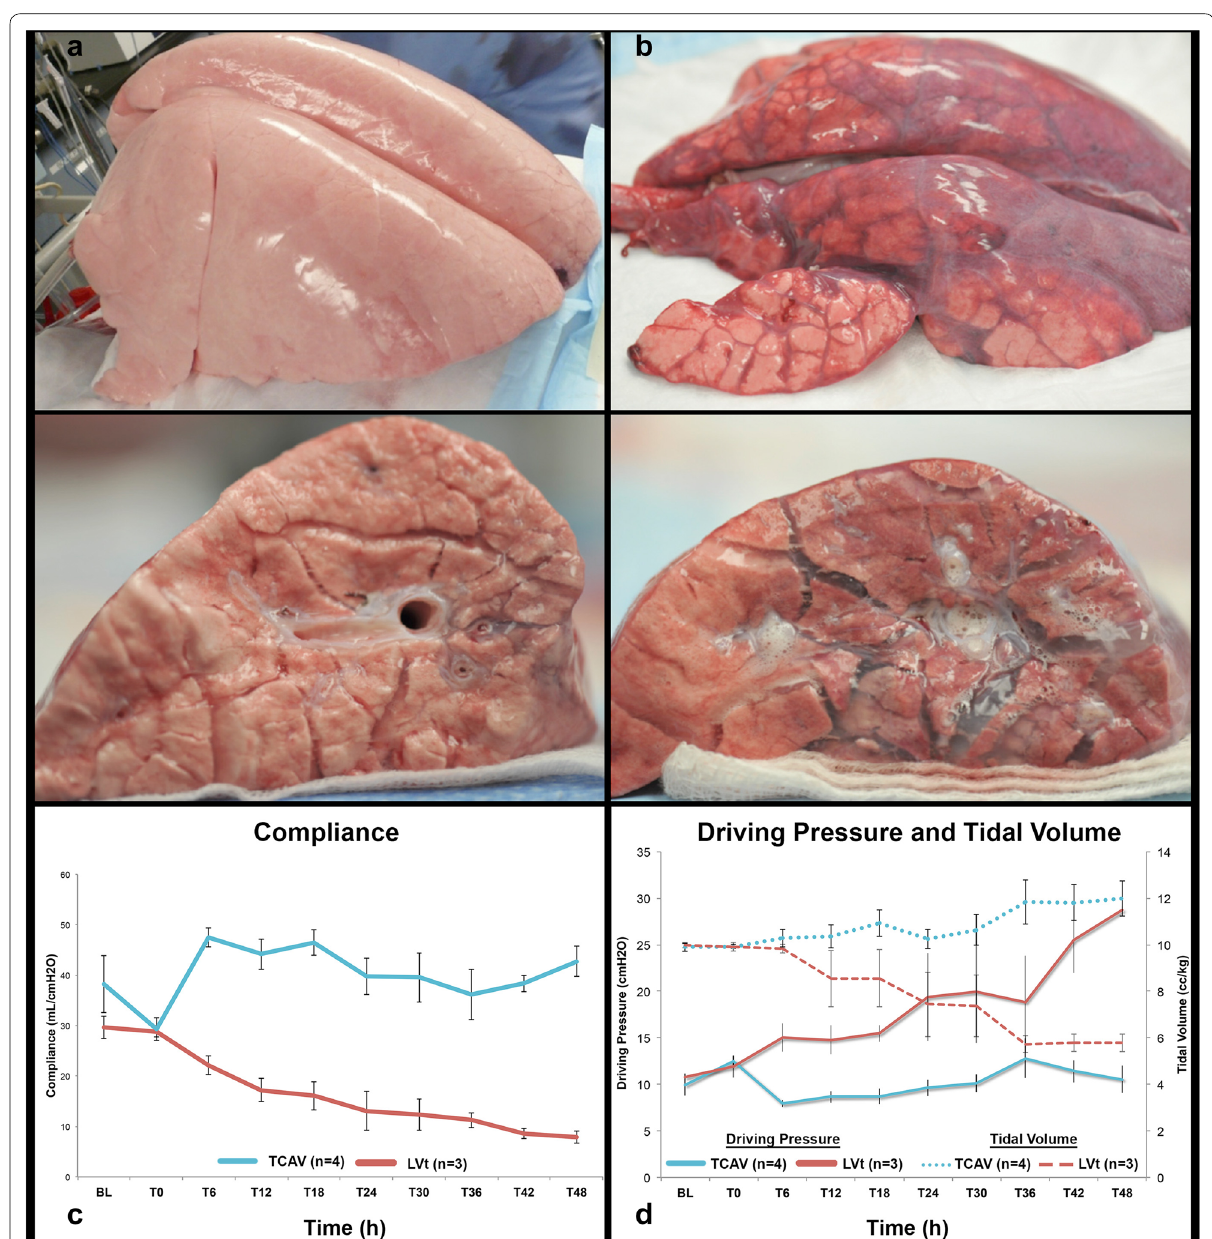
Fig. 7 Gross lung photos with corresponding driving pressure (Δ P ), tidal volume (Vt), and respiratory system compliance ( C RS ) values over time [21]. Two protective mechanical ventilation strategies, the TCAV method ( a ) and the ARDSNet (LVt) method ( b ), were tested in a clinically applicable 48‑h porcine ARDS model of peritoneal sepsis (PS) and gut ischemia/reperfusion (I/R) injury [21]. The evolution of C RS , Δ P , and Vt with time in each group occurred over the 48‑h study period ( c , d ). In the ARDSNet LVt method group, Δ P increased despite the reduction in Vt because of worsening C RS . With the TCAV method, Δ P remained low despite Vt ~ 12 ml/kg because C RS progressively increased ( c , d ). The personalized and adaptive Vt based = on lung C RS (i.e., high C RS large Vt and low C rs small Vt) was also seen in the brain‑dead organ donor (Fig. 5a). Gross lung photos illustrate that the = = TCAV method ( a ) was lung protective, whereas the LVt method ( b ) resulted in severe acute lung injury. Δ P was calculated retrospectively and was not in the publication by Roy et al.